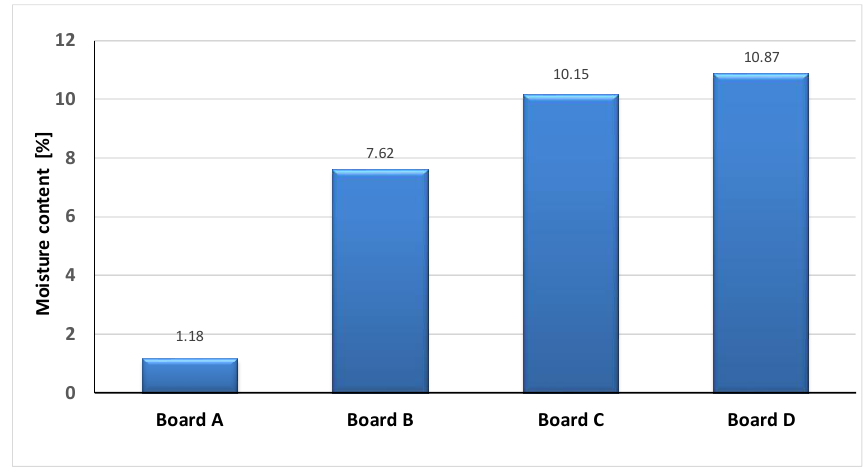
Figure 4. MOR of tested boards versus time of their storage in water. Figure 2. Mass moisture content in tested boards. Figure 2. Mass moisture content in tested